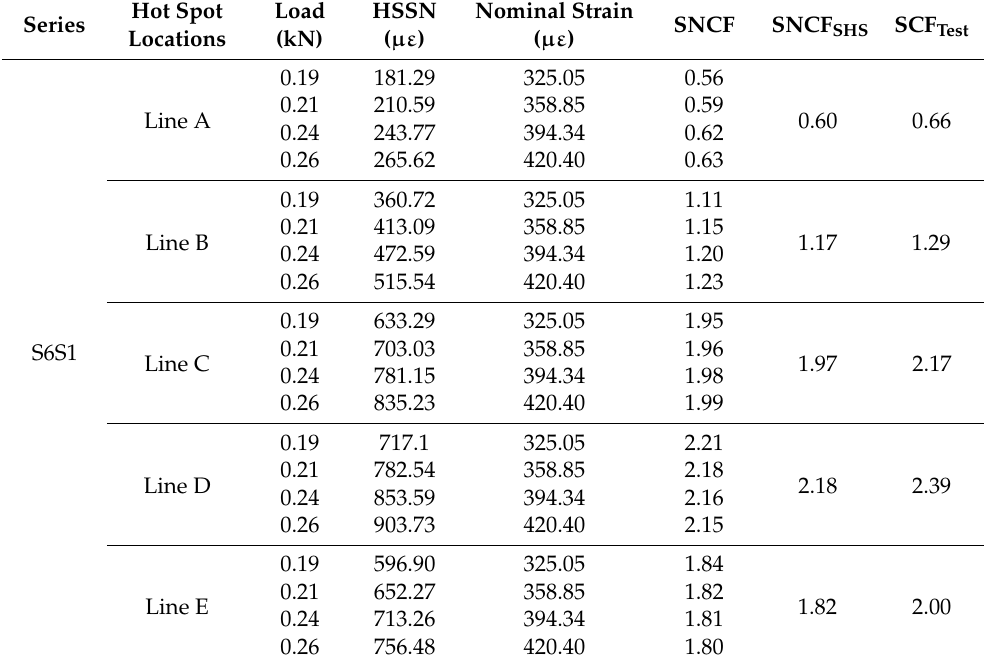
Table 4. Experimental SCFs of concrete-filled SHS-SHS T-joints under in-plane brace